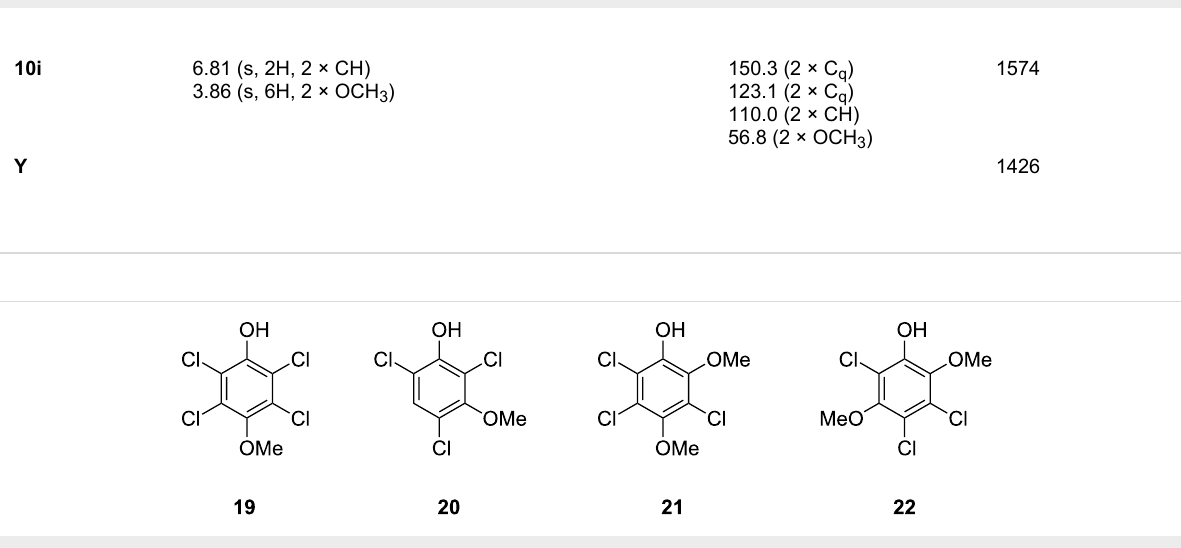
Table 3: NMR spectroscopic data and GC retention indices of all constitutional isomers of dichlorodimethoxybenzene in comparison to natural Y . (continued)